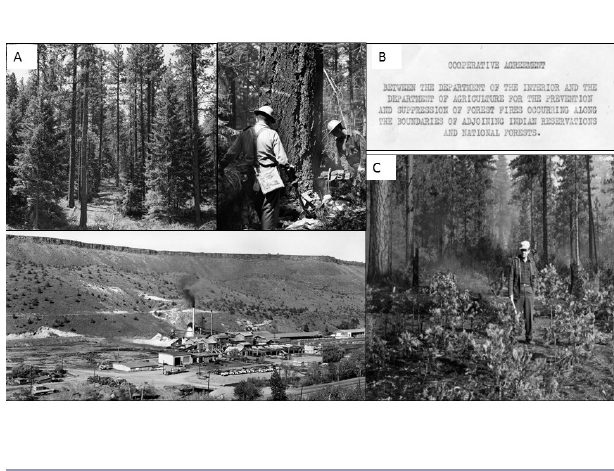
Fig. 5. Example representations of tribal institutions, particularly during the systemization-centralization stage. (A) Tribal community forestry-based economic development, 1959. Source: Weaver (1959). (B) Cross-ownership cooperation between tribal ownership and the U.S. Forest Service to control wildfire hazard. Source: Jones and Galloway (1919). (C) Tolerance for limited experimentation to manage wildfire hazard and promote reforestation of commercial forest species: experimental application of prescribed burn. Source: Weaver